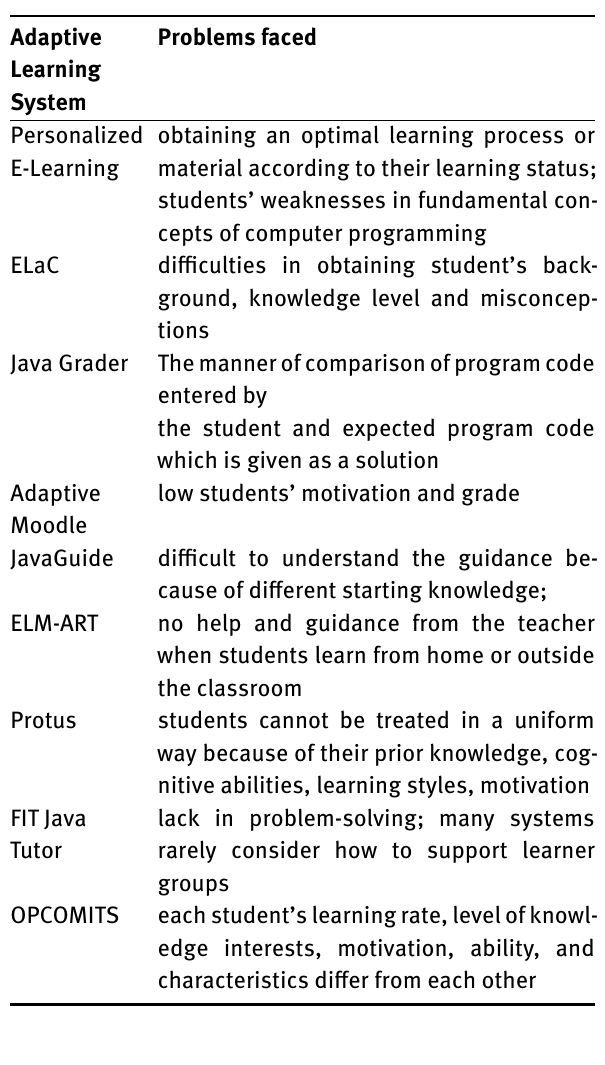
Table 2: Problems faced as a background of developing the